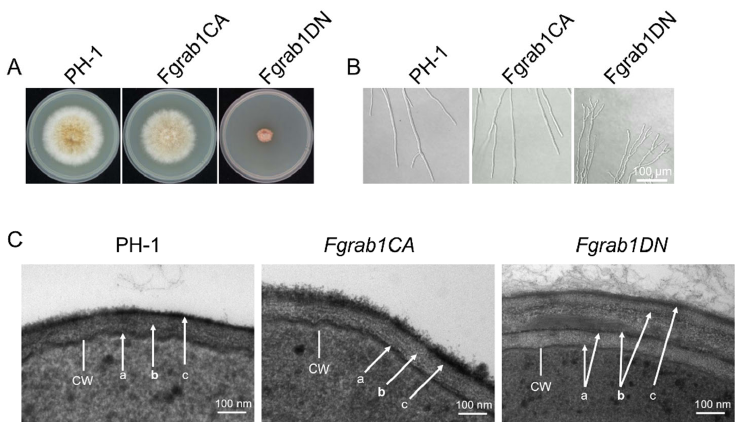
Figure 2. FgRab1 is important for vegetative growth and growth polarity in F. graminearum . ( A ) ( A ) Colony morphology of the wild-type PH-1, Fgrab1CA and Fgrab1DN strains. ( B ) Mycelial Colony morphology of the wild ‐ type PH ‐ 1, Fgrab1CA and Fgrab1DN strains. ( B ) Mycelial morphol ‐ morphology of PH-1, Fgrab1CA and Fgrab1DN . Hyperbranching was observed in the Fgrab1DN ogy of PH ‐ 1, Fgrab1CA and Fgrab1DN . Hyperbranching was observed in the Fgrab1DN strain. ( C ) strain. ( C ) Fgrab1DN displays a thicker cell wall compared to wild-type PH-1. CW: cell wall. Arrows Fgrab1DN displays a thicker cell wall compared to wild ‐ type PH ‐ 1. CW: cell wall. Arrows mark the mark the different layers: a. internal electron-dense layer, b. middle electron-dense layer, c. external different layers: a. internal electron ‐ dense layer, b. middle electron ‐ dense layer, c. external electron ‐ dense layer. electron-dense 2.3. FgRab1 Is Involved in Regulating Conidiogenesis but Not Sexual Reproduction in F.